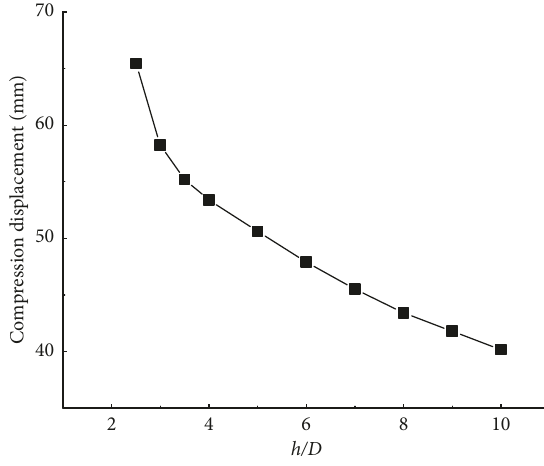
Figure 13: Variation of soil compression displacement.